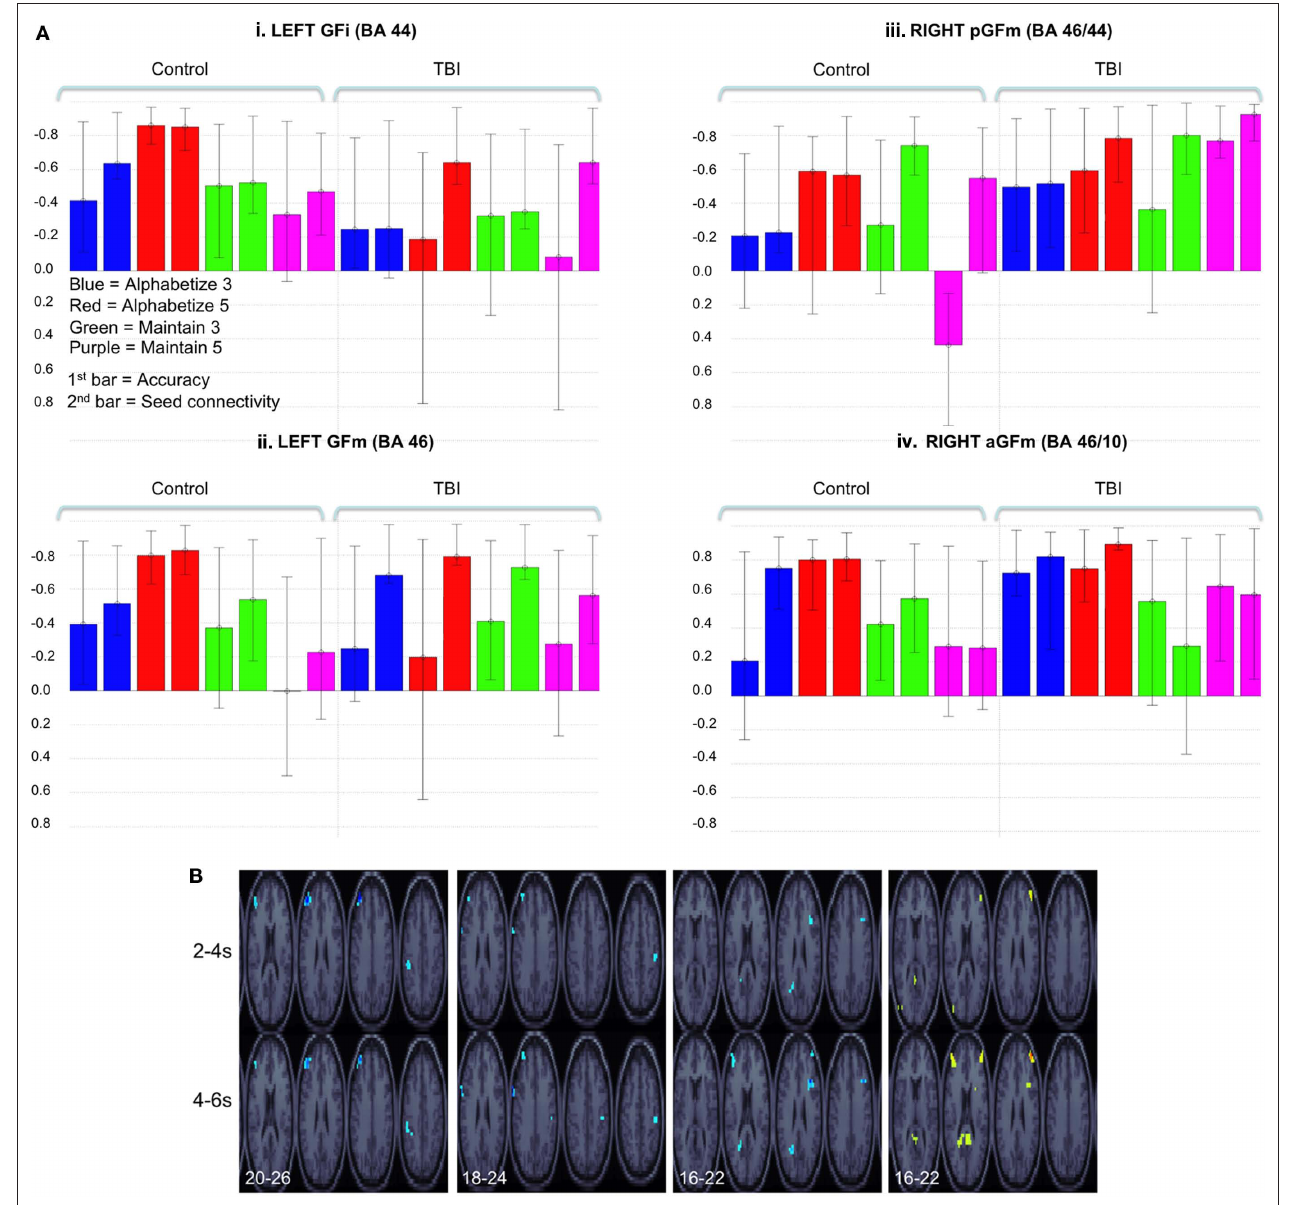
Talairach space ( z ) are indicated in bottom-left (step = 2). Time lags (either 2–4 or 4–6 s post stimulus onset) are indicated on the left of the images. BSR was set at 4 ( p < 10 − 4 , corresponding approximately to a p < 0.0001) and cluster size was > 5 voxels for all images. As noted above, the sign of the correlation and voxel saliences was reversed between images (Ai–iv) . This is reflected in the voxel color coding in (Aiv) . However, this does not affect interpretation; all brain–behavior correlations were